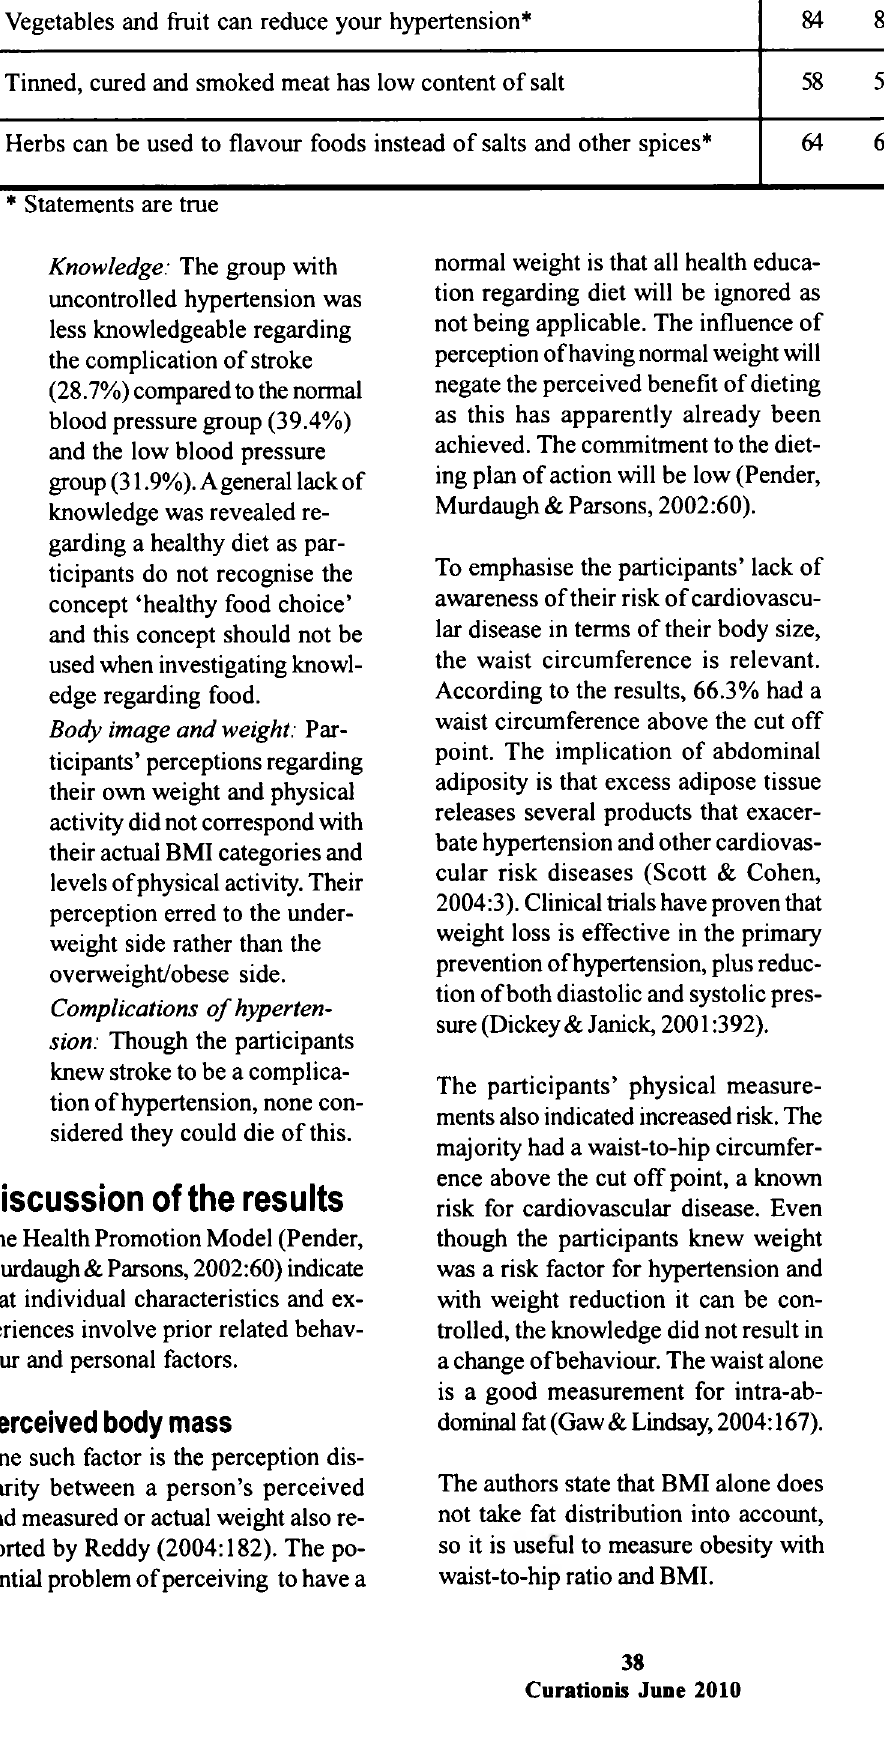
Table 3: Results of true or false questions (n~100) Indicate whether true or false True Fresh fish is high in